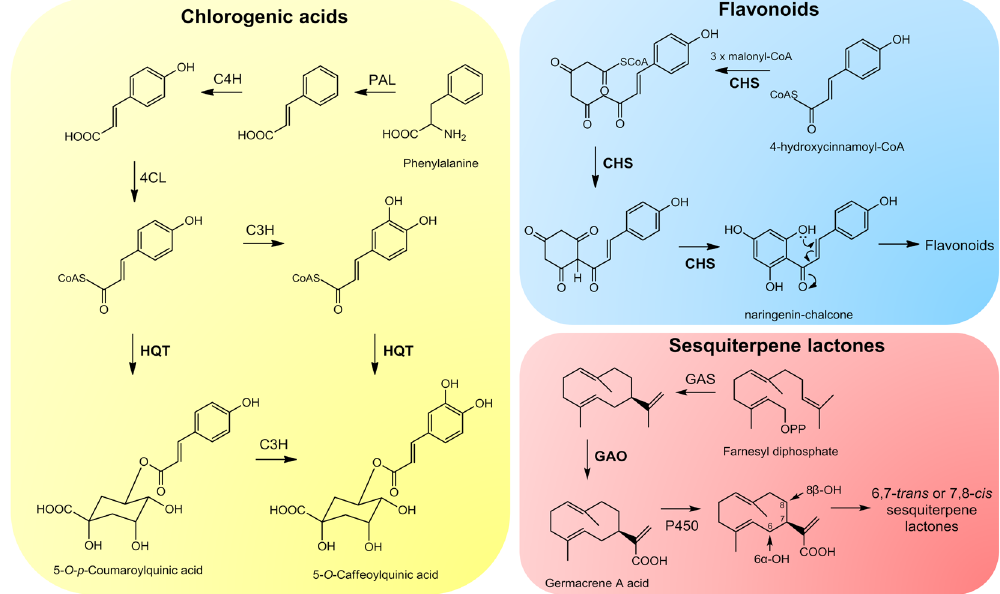
Figure 1. Biosynthetic pathways of chlorogenic acids, flavonoids and sesquiterpene lactones in Asteraceae. Chlorogenic acid enzymes: phenylalanine ammonia lyase (PAL), cinnamate 4 ′ -hydroxylase (C4H), 4-cinnamoyl CoA ligase (4CL), hydroxycinnamoyl CoA: quinate hydroxycinnamoyl transferase (HQT), p -coumaroyl-3 ′ - hydroxylase (C3H); flavonoid enzymes: chalcone synthase (CHS); sesquiterpene lactone enzymes: germacrene A synthase (GAS), germacrene A oxidase